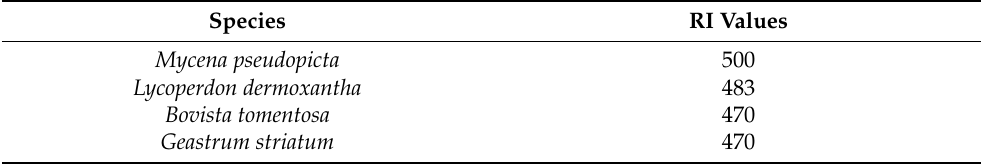
470 Table 3. Group IV. Thermophilic species (with RI values). Species RI Values Species RI Values Cyathus olla 450 Gastrosporium simplex 440 Geastrum campestre 450 Tulostoma squamosum 440 Geastrum minimum 450 Disciseda